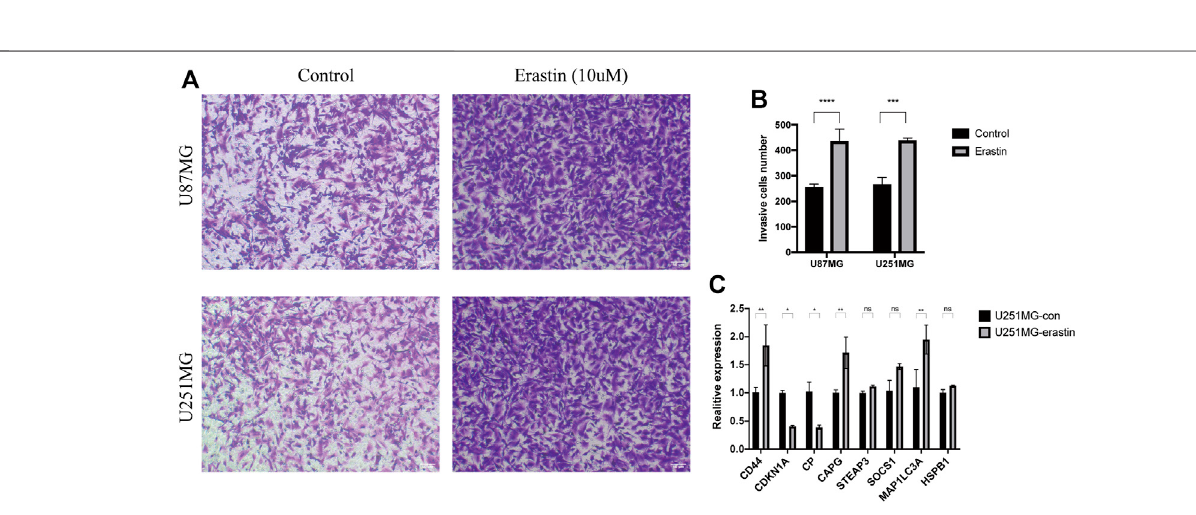
FIGURE 6 | Ferroptosis enhances glioblastoma cell migration (A – B) Light microscopic images and analysis of their data showed enhanced migratory ability of U251MGandU87MGcellstreatedwitherastin(10 μ m)comparedtocontrol (C) qPCRanalysisshowedthattheexpressionofkeygenesisalteredintheerastin(10 μ m)- treated group compared to the control